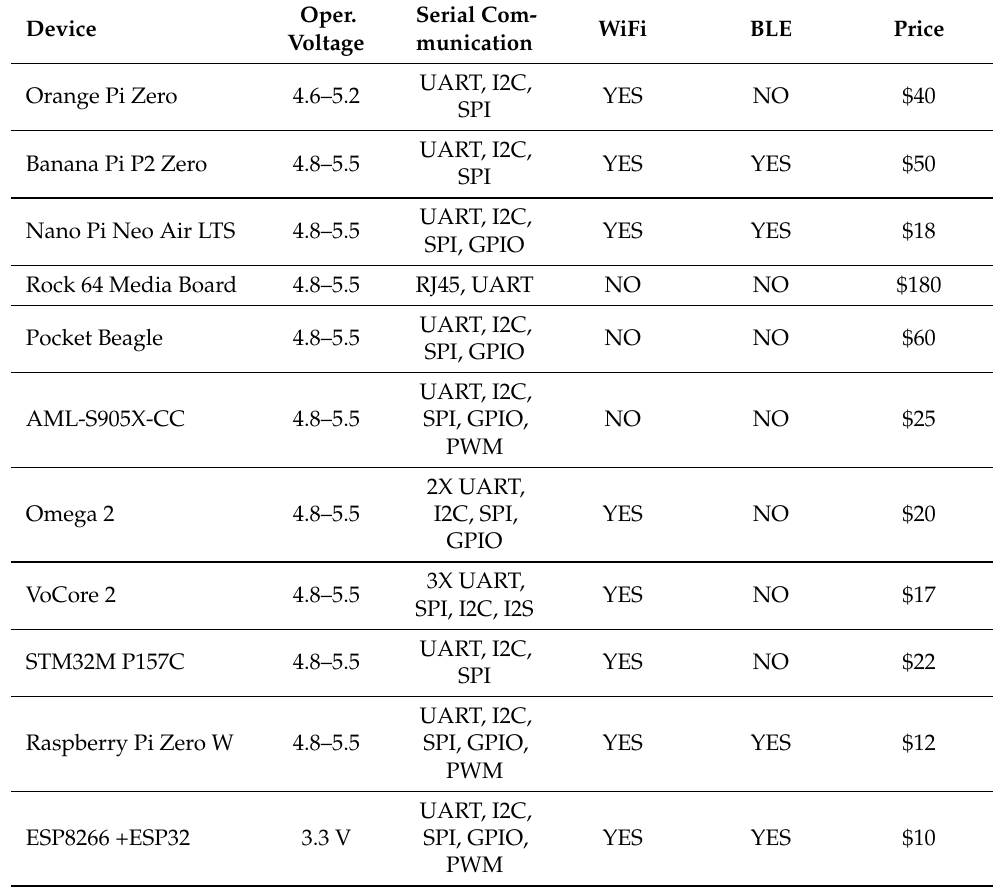
Table 2. Commercially available SBCs (taken from